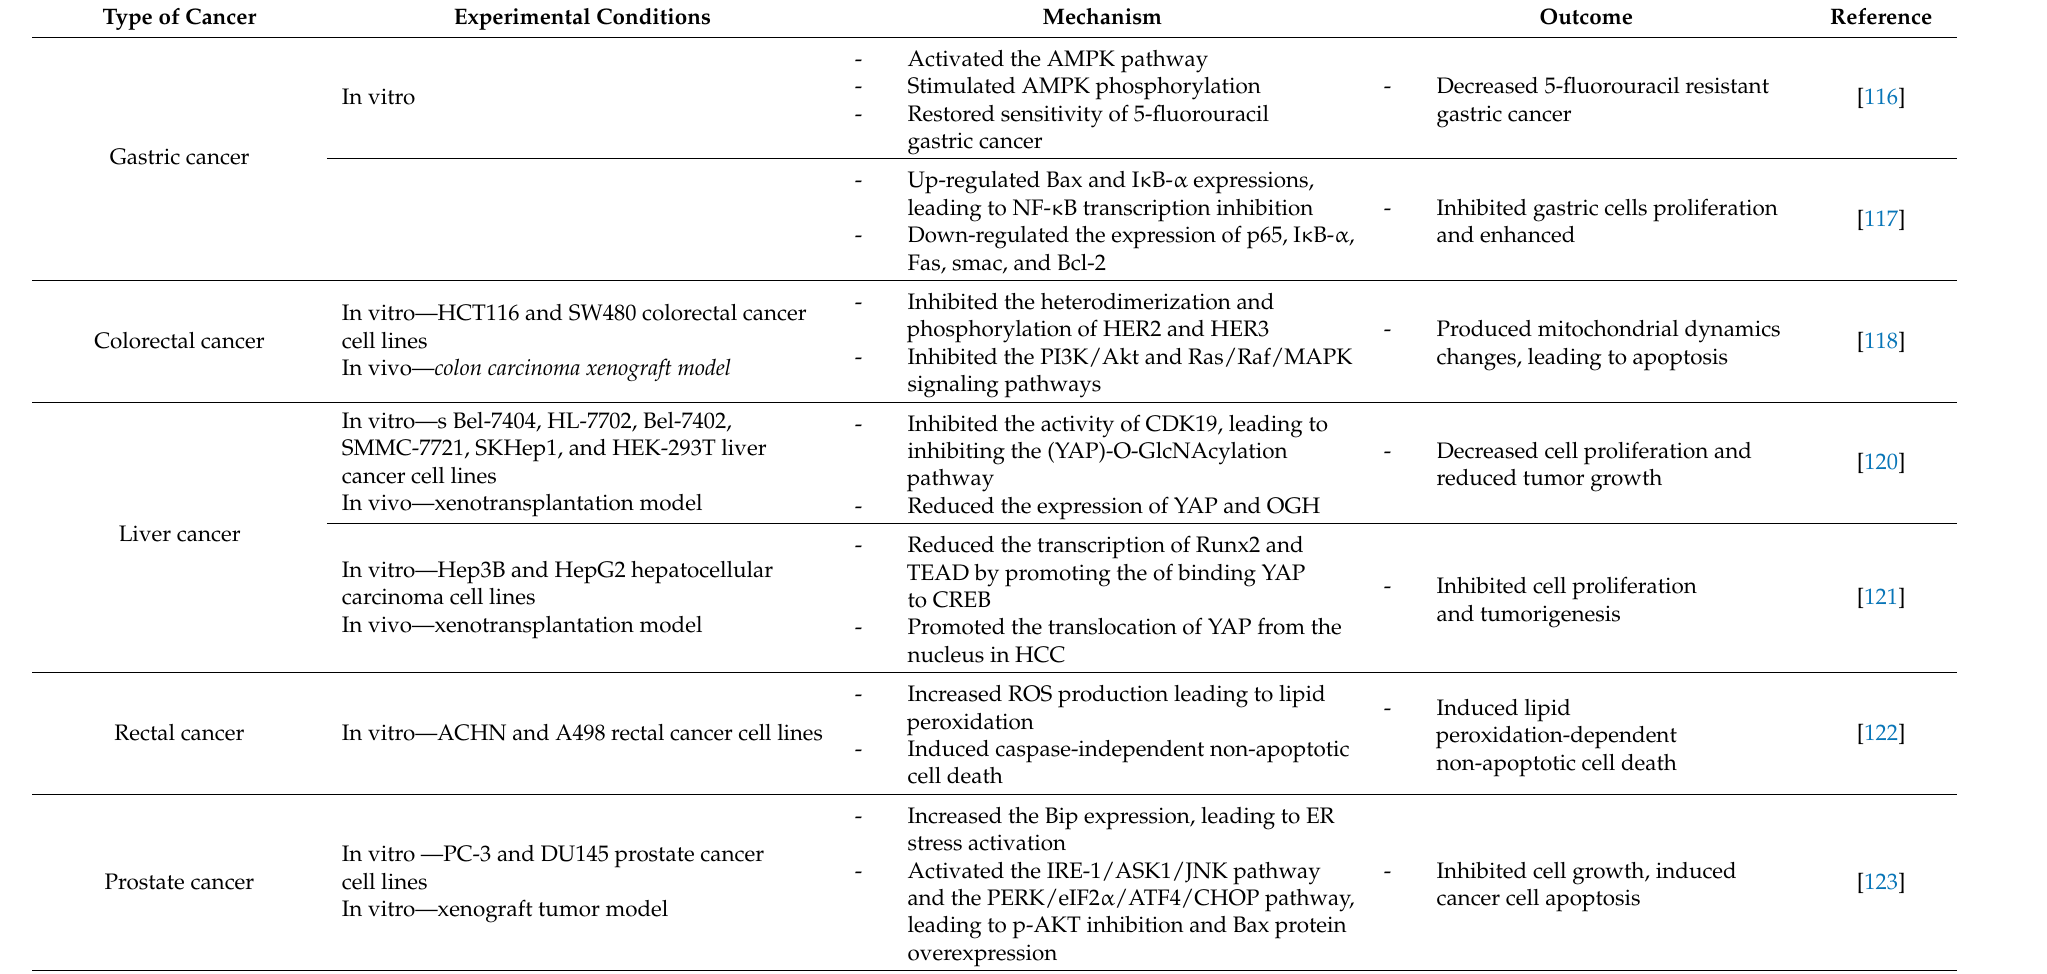
Table 2. In vitro and in vivo biological activity of corosolic acid against different types of